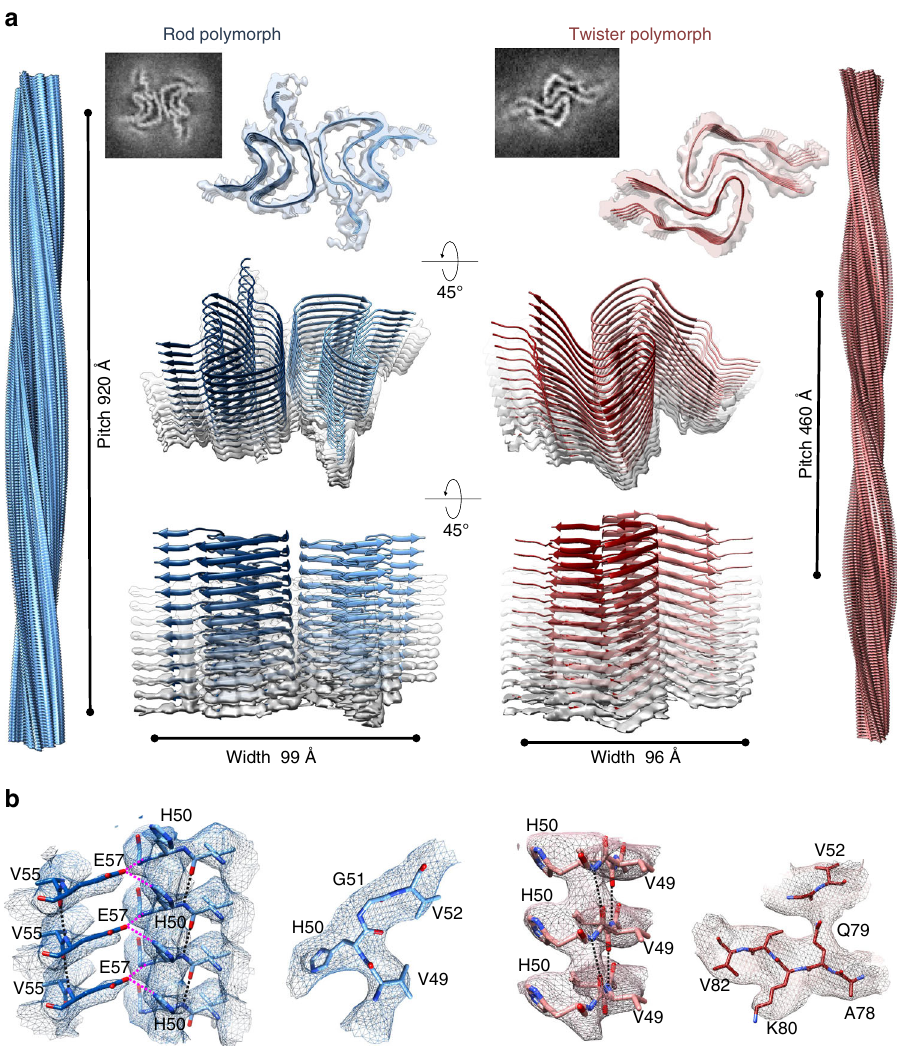
Fig. 2 Cryo-EM structures and atomic models of the aSyn rod and twister polymorphs. a The cryo-EM structures of the rod (left) and twister (right) polymorphs of the full-length aSyn fi brils shown as density slices (top inlet), as semitransparent surfaces overlaid with their atomic models viewed from two different angles (lower panels). The rod (blue) and twister (red) polymorphs contain two proto fi laments composed of stacked β -sheets and packed by an approximate 2 1 screw axis of symmetry. Shown on the left and right sides are the 3D model of the rod and twister fi bril polymorphs, respectively, with their distinctively different helical pitches depicted. b Model validation. Representative regions of density maps of both polymorphs are superimposed with their models showing match of side chain with cryo-EM densities. Intra-proto fi lament hydrogen bonds are shown in black dashed lines, and inter- proto fi lament hydrogen bonds are shown in magenta dashed lines. See details in Supplementary Figures 7 and